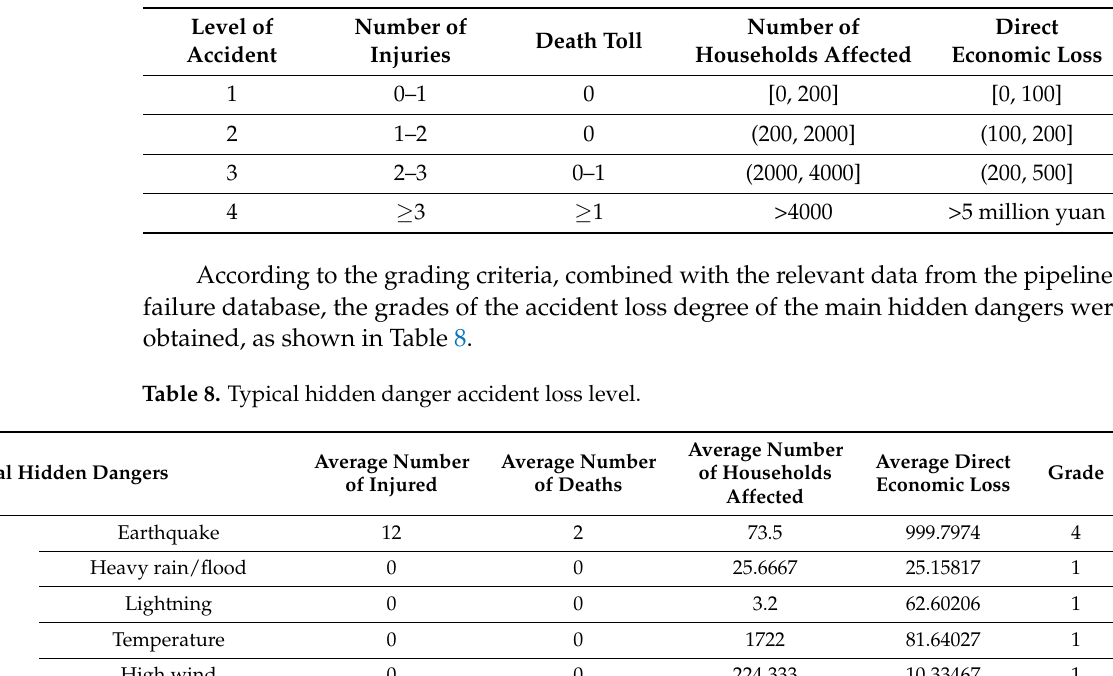
Table 7. Accident loss degree reference standard.